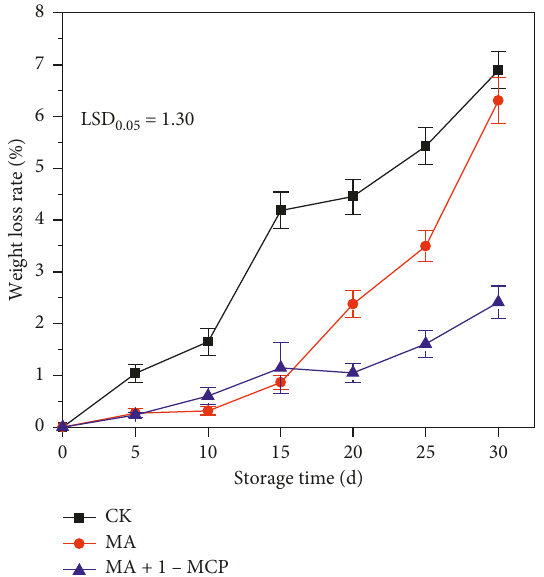
Figure 2: Effects of MA and MA+1-MCP treatment on weight loss rate of fig fruit during storage at − 1 ° C for 30 days. Data represent the mean value of five measurements ± the standard errors. LSDs represent significant differences at the 0.05